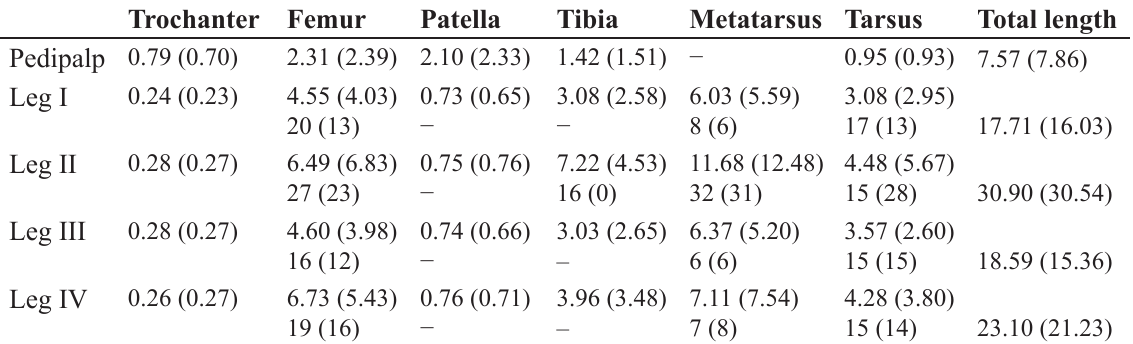
Table 1. Nemaspela borkoae sp. nov. holotype, ♂ (allotype in parentheses). Length of appendage- segments in millimeters. In the rows for the legs I−IV, the upper row indicates the length of the segments and the lower row the number of pseudoarticles, and for tarsus the number of